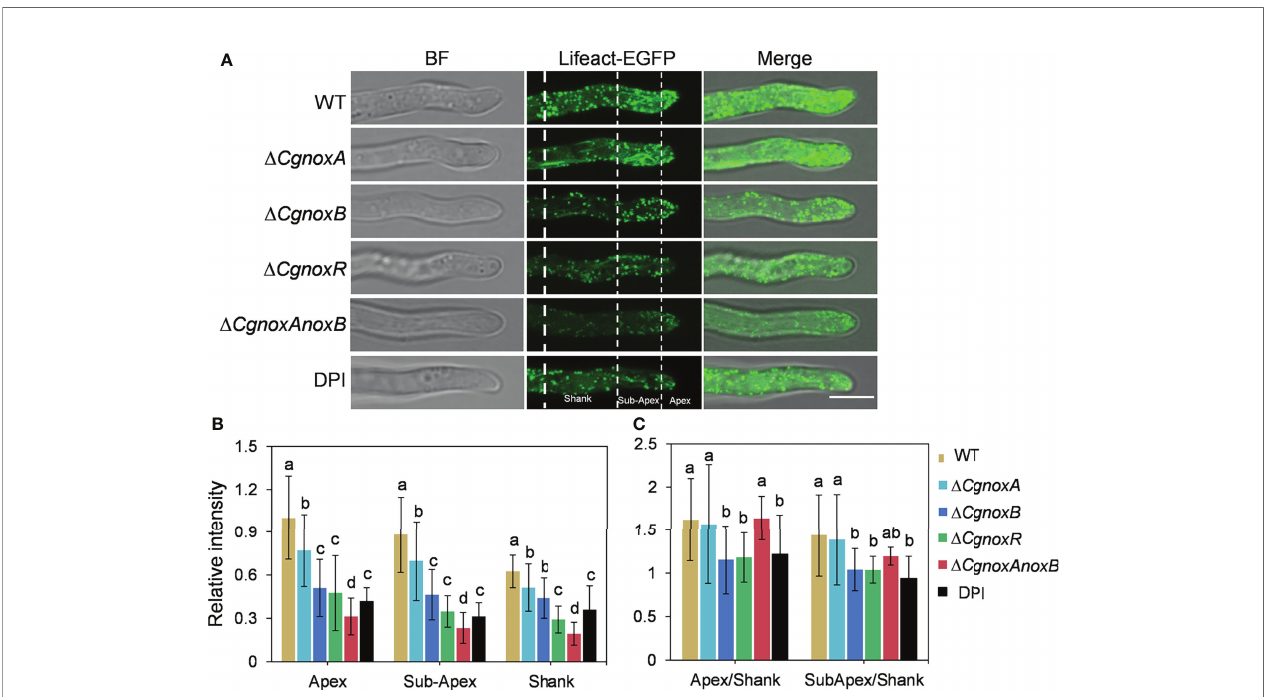
FIGURE 6 | CgNOX regulates the actin fi lament structure in the tip of the germ tube of C. gloeosporioides . (A) Lifeact-EGFP-labeled actin fi lament structures in WT (DPI treatment or not), D CgnoxA , D CgnoxB , D CgnoxR , and D CgnoxAnoxB strains. The tip of germinated hypha was divided into three zones as apex (0 – 2 m m from tip), subapex (2 – 7 m m from tip), and shank (7 – 15 m m from tip) by white dotted lines. Scale bar = 5 m m. (B) The relative amount of actin fi laments in the tip of germinated hypha in WT, D CgnoxA , D CgnoxB , D CgnoxR , and D CgnoxAnoxB strains expressing Lifeact-EGFP. The amount of actin fi lament within the apex, subapex, and shank was measured. The fl uorescence intensity of the apex in WT strain was converted to 1, and the relative amount of actin fi lament was plotted. At least 10 hyphae were measured for each strain. Bars represent standard deviations (SD). Columns with different letters indicate signi fi cant difference (p < 0.05). (C) Quanti fi cation of the distribution of actin fi laments in the tip of germinated hypha in WT (DPI treatment or not), D CgnoxA , D CgnoxB , D CgnoxR and D CgnoxAnoxB strains expressing Lifeact-EGFP. At least 10 hyphae were measured for each strain. Bars represent standard deviations (SD). Columns with different letters indicate signi fi cant difference (p <